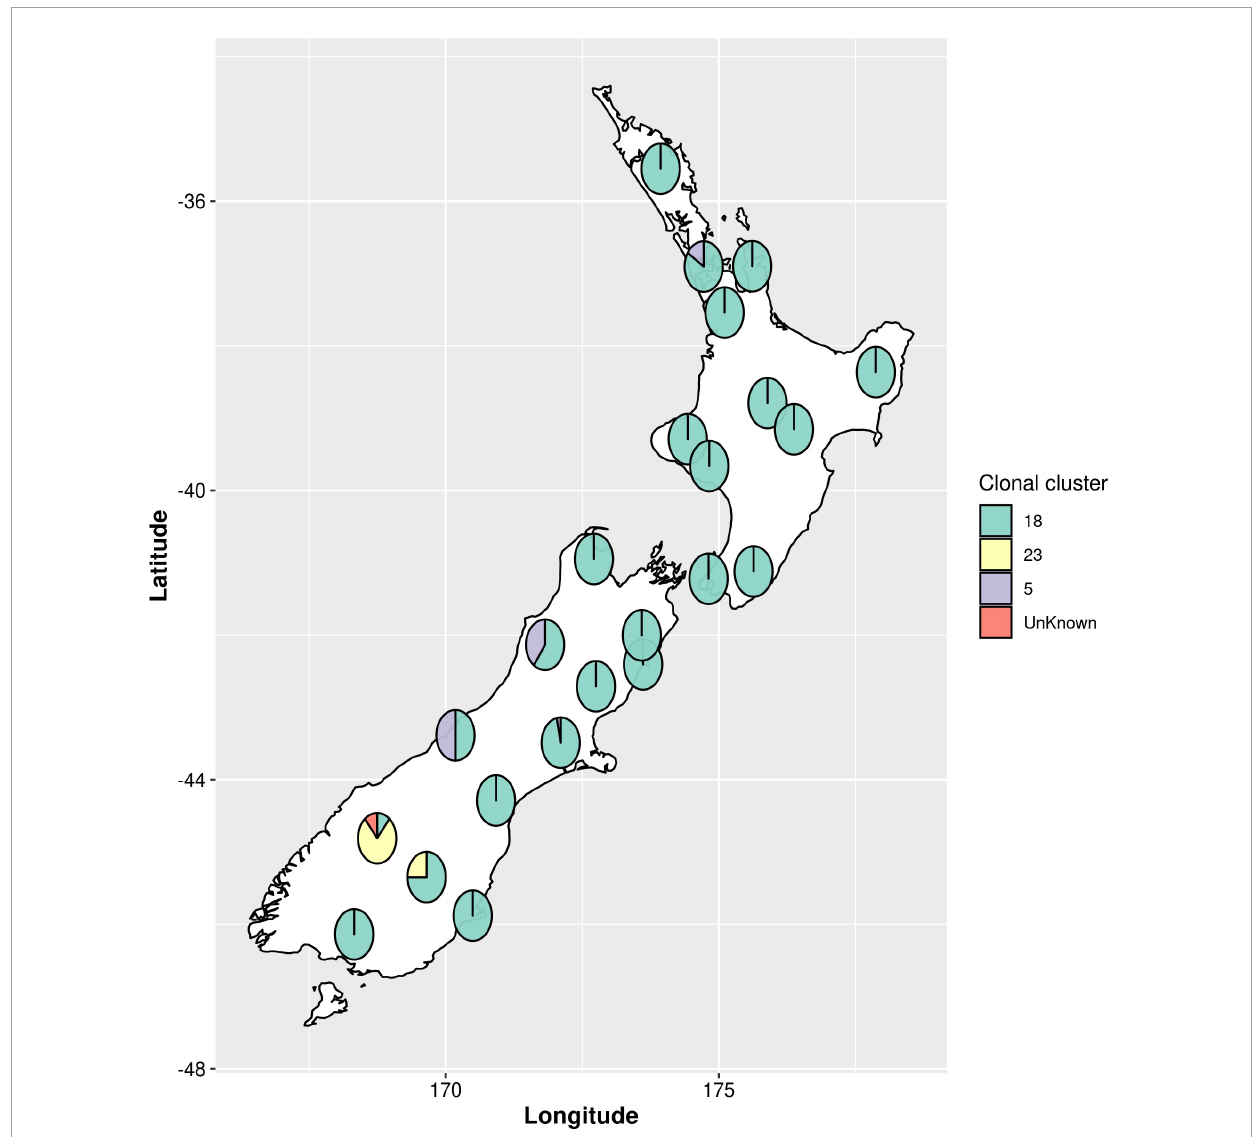
FIGURE1 Geographic distribution of Paenibacillus larvae multi-locus sequence types (MLST) across New Zealand. Pie charts show the proportions of sequence types present in each region. The sequence types are grouped as clonal clusters. Each clonal cluster consists of the main sequence type (ST) and the single nucleotide polymorphism (SNP) variants of the main sequence type. An untypable genome, referred to in the figure as “unknown”, shared six loci with ST23 but the seventh loci was not